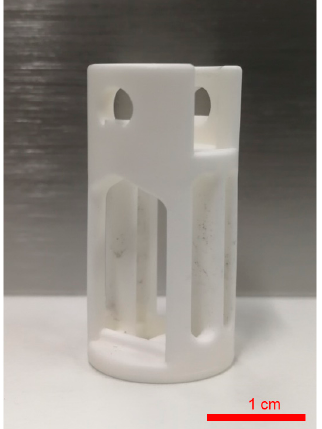
Figure 1. An example of a 3D-printed ceramic component: sintered alumina sample holder, which is used in our other works for molten chloride corrosion tests. In this work, the compatibility of 3D-printed ZrO 2 and Al 2 O 3 ceramics with molten chlorides is investigated. The as-received 3D-printed ceramics are immersed in molten MgCl 2 /NaCl/KCl (60/20/20 mole%) at 700 °C for 600 h under argon atmosphere to study their corrosion resistance in contact with the strongly corrosive molten chloride salt. Moreover, they are exposed in argon atmosphere at 700 °C for 600 h to investigate the effect of a pure thermal treatment without molten salt. The material properties and micro- structures of all the 3D-printed ceramics are investigated through 3PB mechanical testing and additional analysis with scanning electron microscopy (SEM), energy dispersive X- ray (EDX) scanning and X-ray diffraction (XRD). The effect of the molten salt exposure on the 3D-printed ZrO 2 and Al 2 O 3 ceramics is discussed based on the tests and analysis, in order to determine if they can be used as construction materials in contact with strongly corrosive molten chloride salts. 2. Experimental 2.1. Chemicals and 3D-Printed Ceramics KCl (Alfa Aesar, Germany, >99 wt.%), NaCl (Alfa Aesar, Germany, >99 wt.%) and anhydrous MgCl 2 (Magnesia, Germany, >99 wt.%, technical grade) were used to synthe- size the salt mixture of MgCl 2 /KCl/NaCl (60/20/20 mole%) for immersion tests. The 3D- printed specimens were provided by Steinbach AG, Germany, with 99.8% purity, 1.6% porosity and 98.4% of its theoretical density (3.985 g/cm 3 ) for Al 2 O 3 and 99.9% purity, 0.6% porosity and 99.8% of its theoretical density (6.088 g/cm 3 ) for ZrO 2 [19]. The ZrO 2 was stabilized with 3 mole% Y 2 O 3 . All specimens were produced by Lithography-based Ce- ramic Manufacturing (LCM) [17] on a CeraFab-system from Lithoz (Vienna, Austria) us- ing LithaLox 350 for Al 2 O 3 and LithaCon 3Y 230 D for ZrO 2 . In the printing, a slurry of ceramic particles and photo-active polymer was exposed layer by layer to form the 3-di- mentional part. After exposure, the residual not-polymerized slurry was cleaned, then the polymer phase in the green body was released by tempering (Al 2 O 3 : 134 h preconditioning up to 120 °C and 102 h debinding up to 1100 °C; ZrO 2 : 134 h preconditioning up to 120 °C and 58 h debinding up to 600 °C) followed by sintering (Al 2 O 3 : 48 h up to 1600 °C; ZrO 2 : 28 h up to 1450 °C) to the final product.